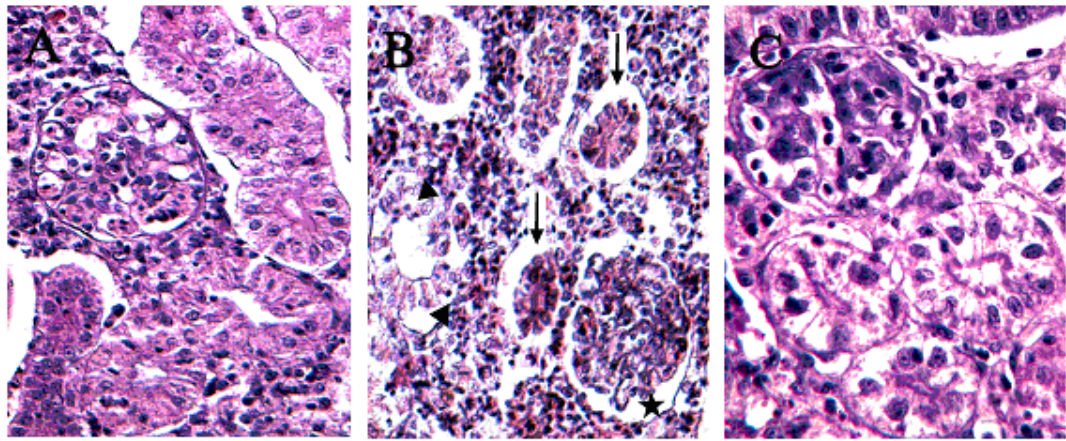
FIGURE 5 . H&E-stained kidney sections of bighead carp collected from the fish pen in Meiliang Bay of Taihu Lake. (A) An example of a normal kidney, which was the specimen obtained during April and May, 2004, 400×; (B) an example of dilation of Bowman’s capsule in the glomeruli (asterisk), vacuolation (arrows), and atrophy (arrow heads) in the proximal tubules, which was typical of kidney sections obtained during July and August, 2004, 400×; (C) an example of recovery of kidney structure, which was typical of liver sections obtained from November 2004 to March 2005,